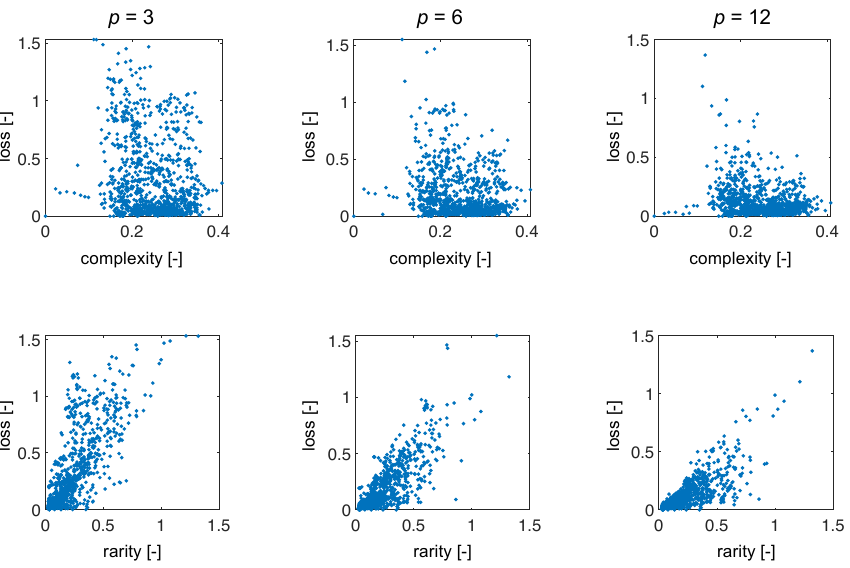
Figure 9. Here, we show the results for loss as a function of complexity (top row) and as a function of rarity (bottom row) for three representative encoder